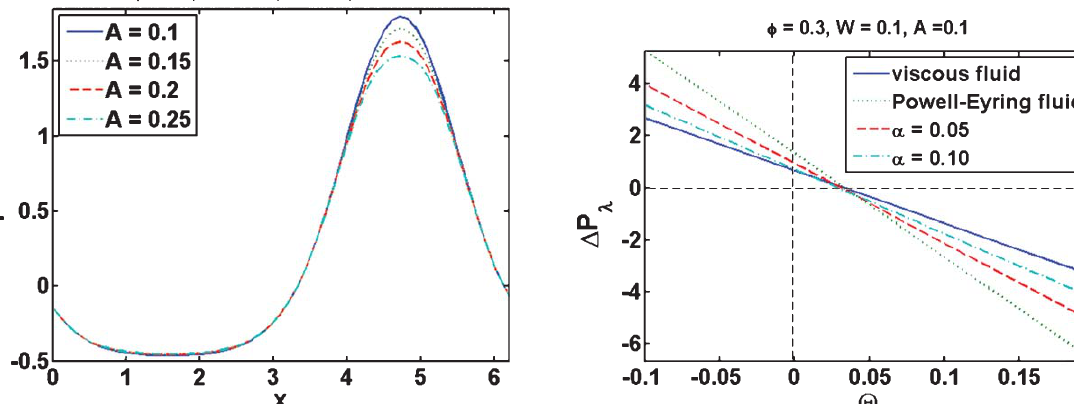
Fig. 11. Variation in dp/dx against x for different values of fluid parameter ( A ).